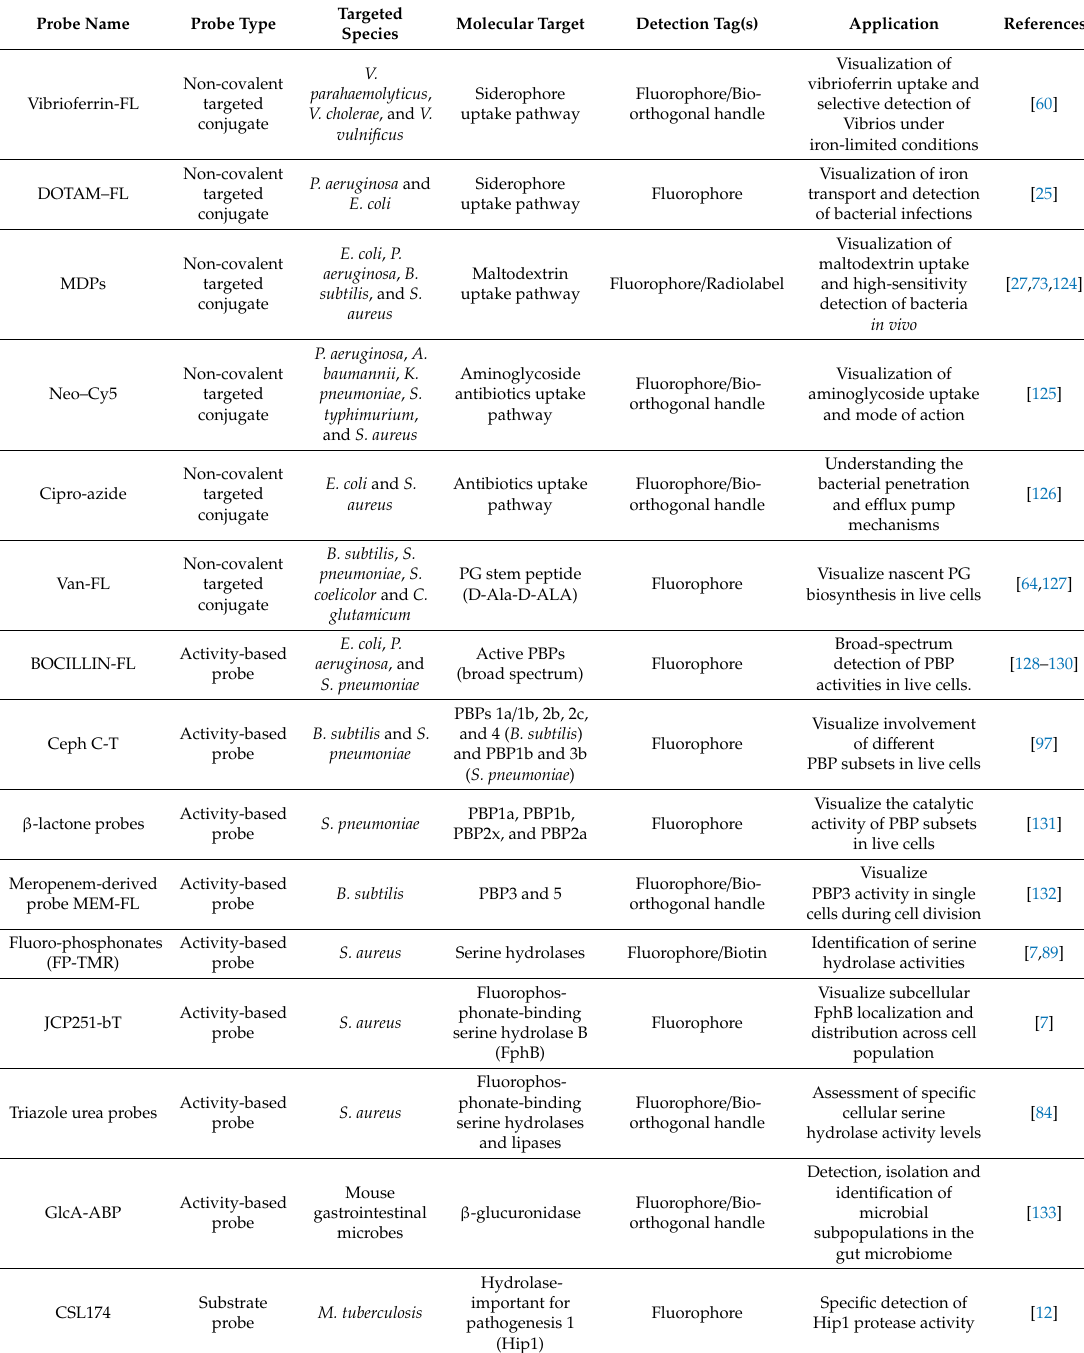
Table 1. Chemical probes and their application in visualizing bacterial structure and